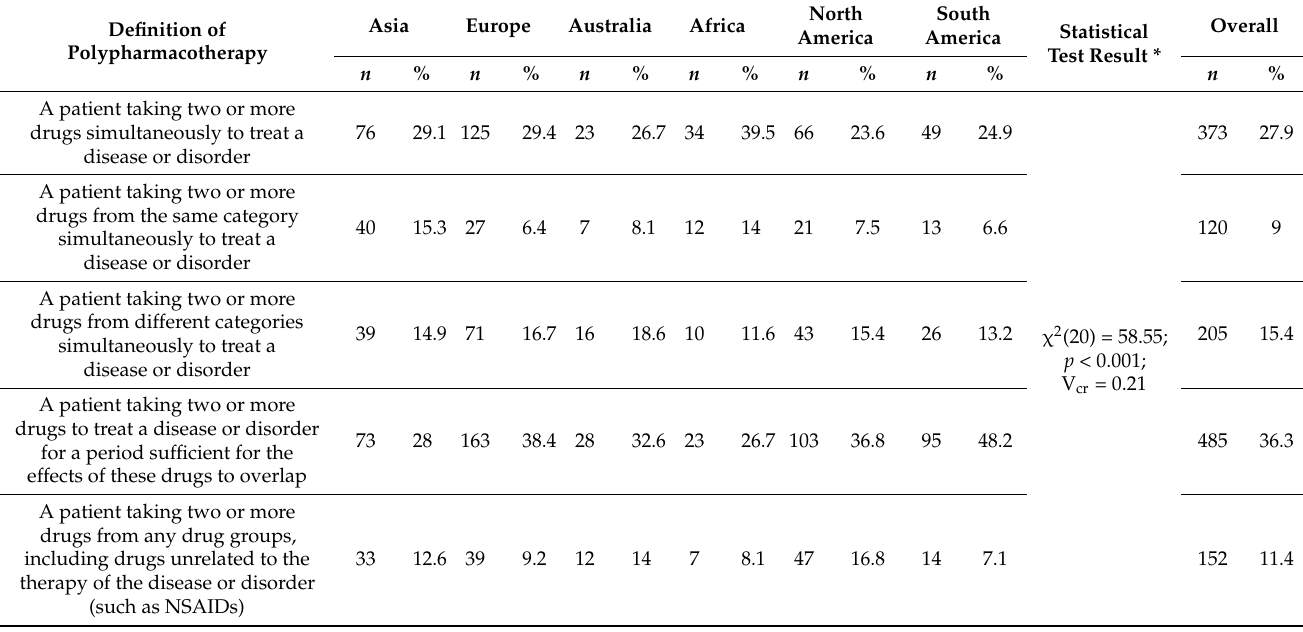
Table 2. Psychiatrists’ answers on the definition of